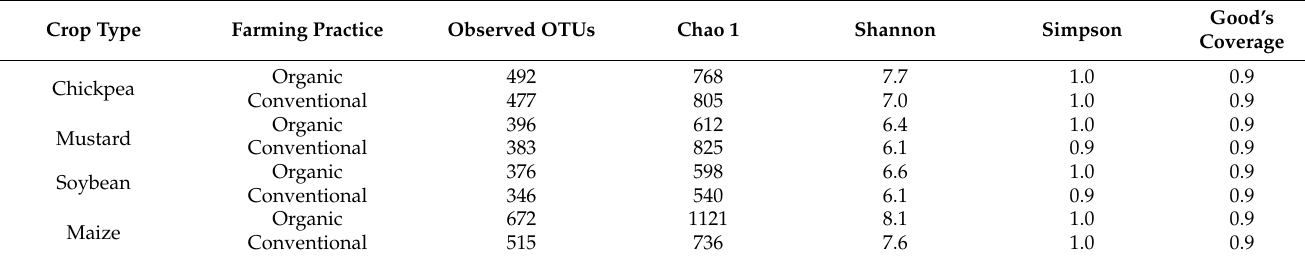
Table 1. Diversity indices (rarefied at minimum library size, i.e., 2629 reads).